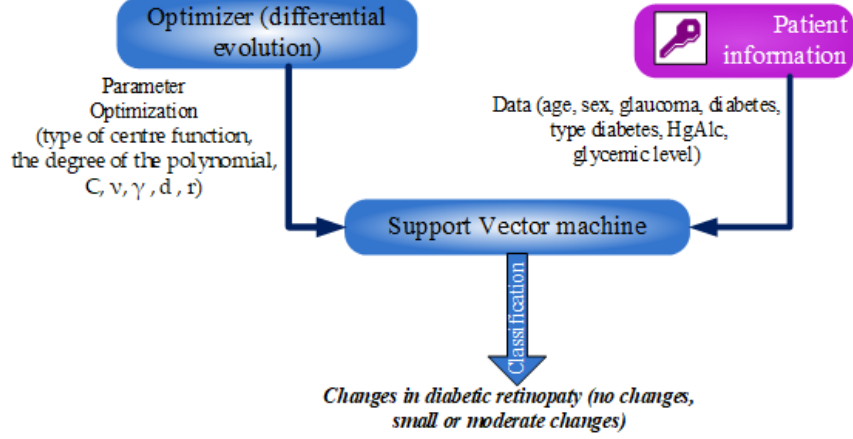
Figure 1. Workflow of the classification approach. sDE-SVM and DE-SVM are based on two different variants of the DE algorithm, the basic mechanisms of DE and SVM remaining